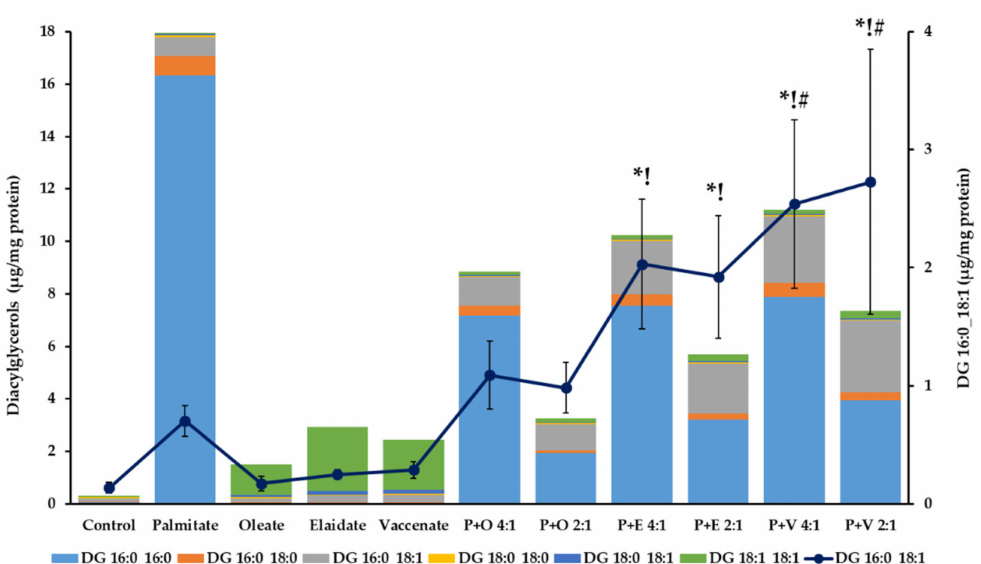
Figure 6. Diglyceride content of hepatoma cells in lipotoxicity. Cells were treated with BSA- conjugated palmitate, oleate, elaidate or vaccenate (800 µ M) or with palmitate (800 µ M) and oleate, elaidate or vaccenate at a 4:1 or 2:1 molar ratio (200 or 400 µ M) at 70–80% confluence for 8 h. The amount of six relevant diglycerides (columns) was measured by LC-MS/MS. Data were normalized to the total protein content of the samples and are shown as mean values of at least four independent experiments (see the mean and S.D. values in Table S7). DG 16:0_18:1 contents are also shown separately (line, right axis) as mean values ± S.D.; n ≥ 4; statistically significant differences: * p < 0.05 vs. BSA treated control; ! p < 0.05 vs. palmitate treated samples; # p < 0.05 vs. palmitate and oleate treated cells in case of combinational treatments at the corresponding